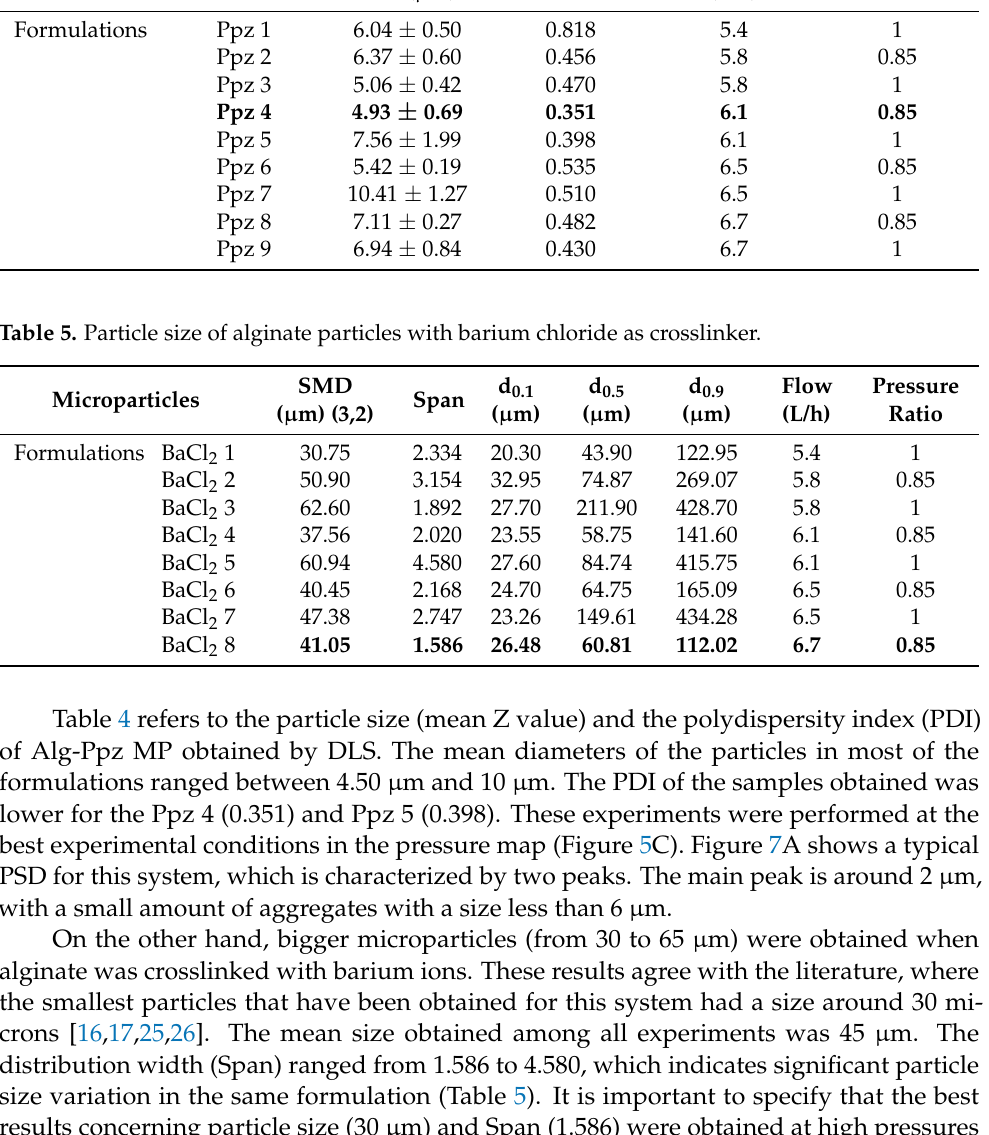
Table 4. Particle size of alginate (1% w / w ) particles with piperazine as crosslinker. Microparticles